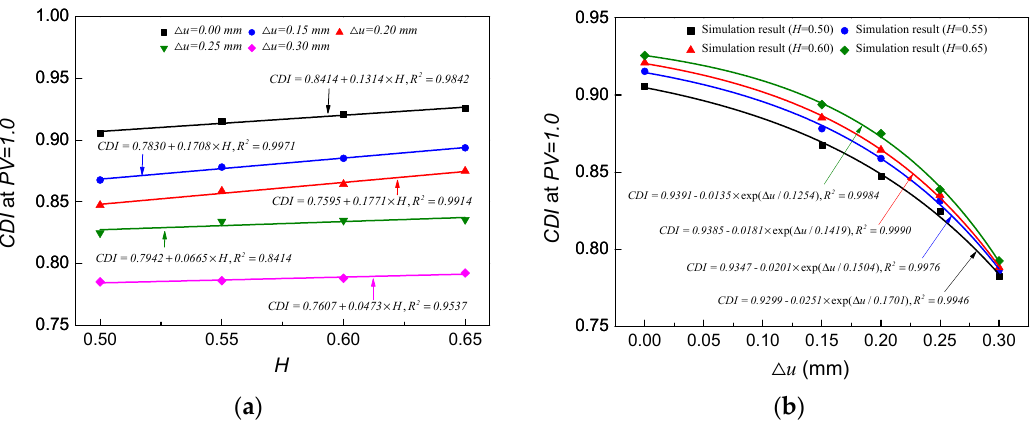
Figure 18. Relationships between the CDI ( PV = 1.0) and H or Δ u : ( a ) CDI versus H ; ( b ) CDI versus Δ u .